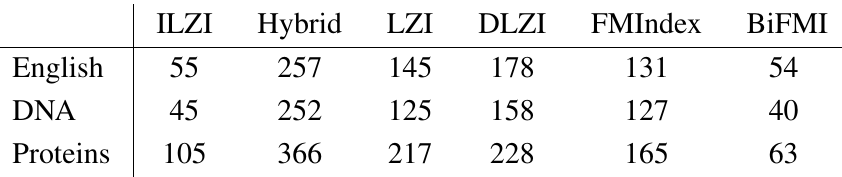
Table 1. Memory peaks, in Megabytes, for the different approaches when k = 6